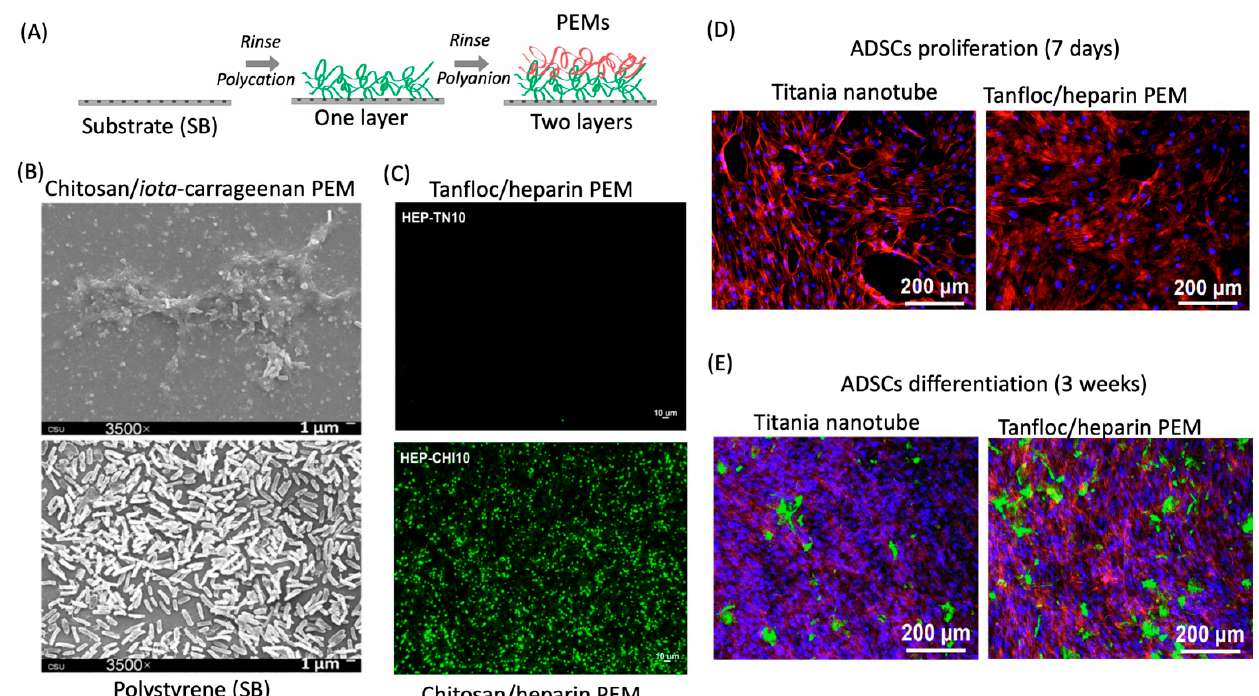
Figure 10. Schematic of PEM assembly onto a oxidized solid substrate ( A ) (adapted with permission from Reference [238]; published by Royal Society of Chemistry, 2019. SEM images of chitosan/ iota -carrageenan PEM (15 layers) and native polystyrene (solid substrate, SB) seeded with P. aeruginosa after 6 h of incubation ( B ). Adapted with permission from Reference [37]; published by Elsevier, 2020. Representative fluorescence images of adhered platelets stained with calcein-AM on Tanfloc/heparin and chitosan/heparin PEMs (10 layers) ( C ). Adapted with permission from Reference [154]; published by Elsevier, 2020. Fluorescence images of adipose-derived mesenchymal stem cells (AMSCs) stained with DAPI (blue) and rhodamine-phalloidin (red) imaged on the titania nanotubes and Tanfloc/heparin PEM (5 layers) after 7 days of culture ( D ). Adapted with permission from Reference [140]; published by Elsevier, 2021. Representative immunofluorescence microscopy images of ADSCs after 3 weeks of induced osteogenesis on titania nanotubes and Tanfloc/heparin PEM (5 layers), in which the green stain indicates osteocalcin ( E ). Adapted with permission from Reference [140]; published by Elsevier, 2021.